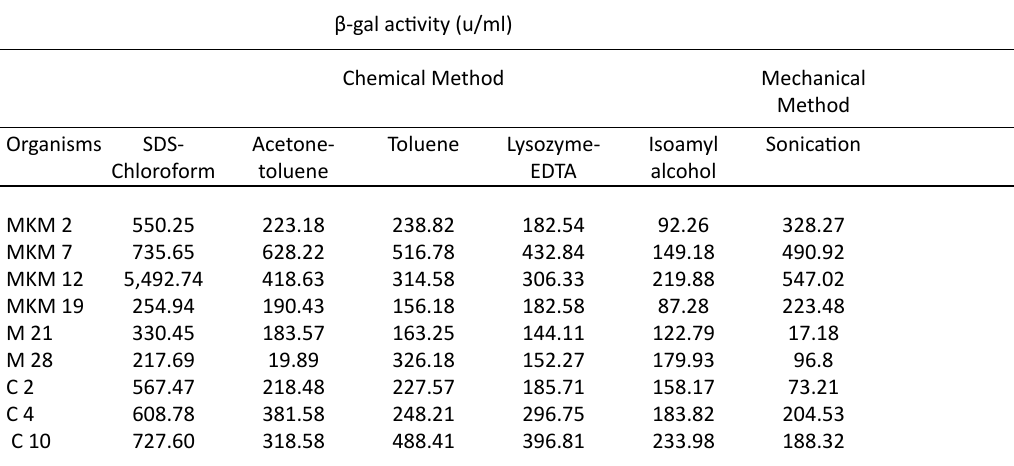
Table 1. Different extraction methods of potential isolates and their β-gal activity. Milk kefir in milk isolates (MKM), Milk isolates (M), and Curd isolates (C)